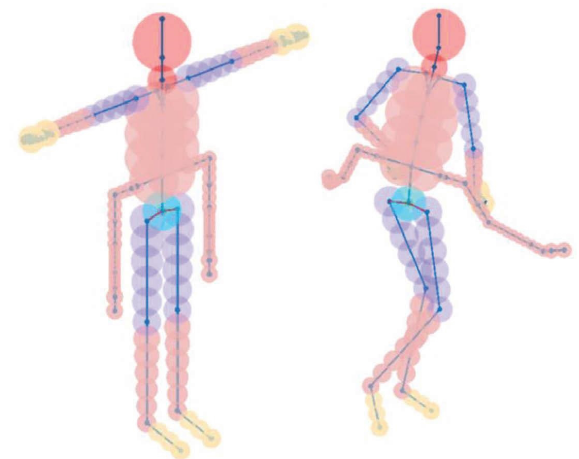
Figure 1: Schematic diagram of a human-SRL skeleton envelope